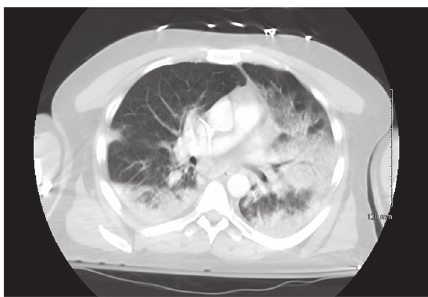
Figure 1: Computed tomography scan (CT) of the chest showing infiltrates in both lower lung